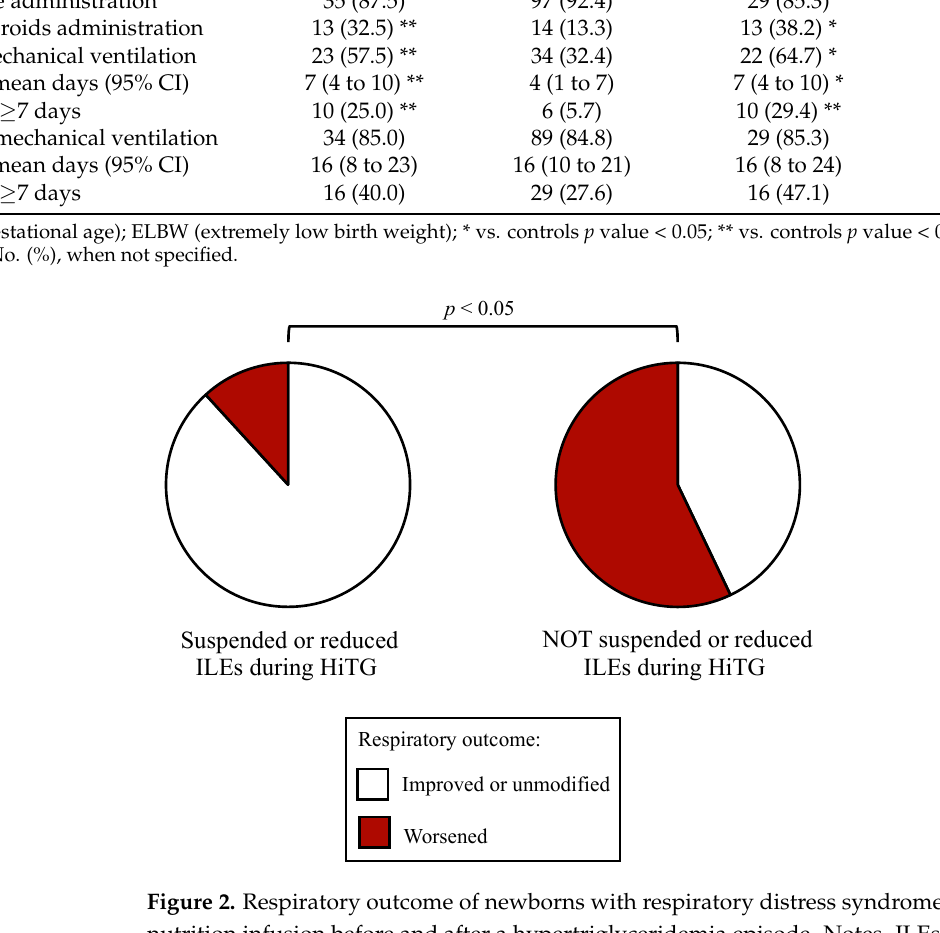
Table 2. Respiratory outcome of neonates with hypertriglyceridemia compared with controls.